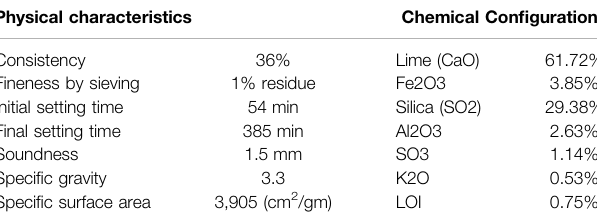
TABLE 1 | Physical and chemical characteristics of OPC.